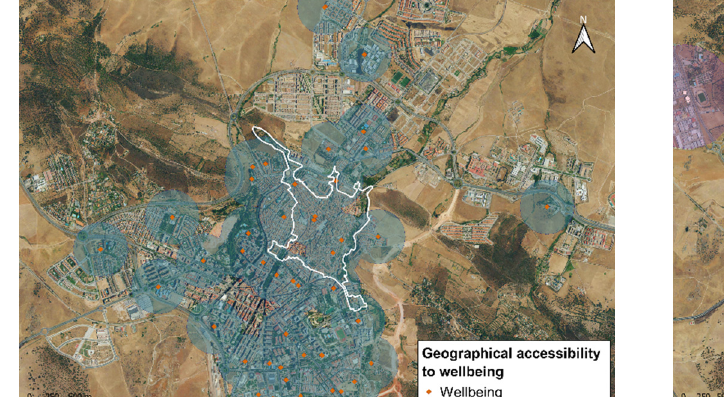
Table 6. Results overview.